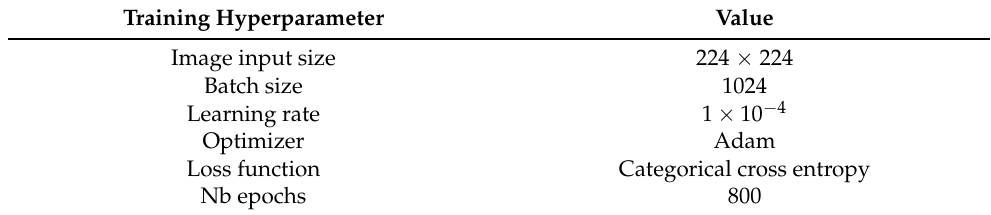
Table 4. Hyperparameters used for the training of the car model classifier.